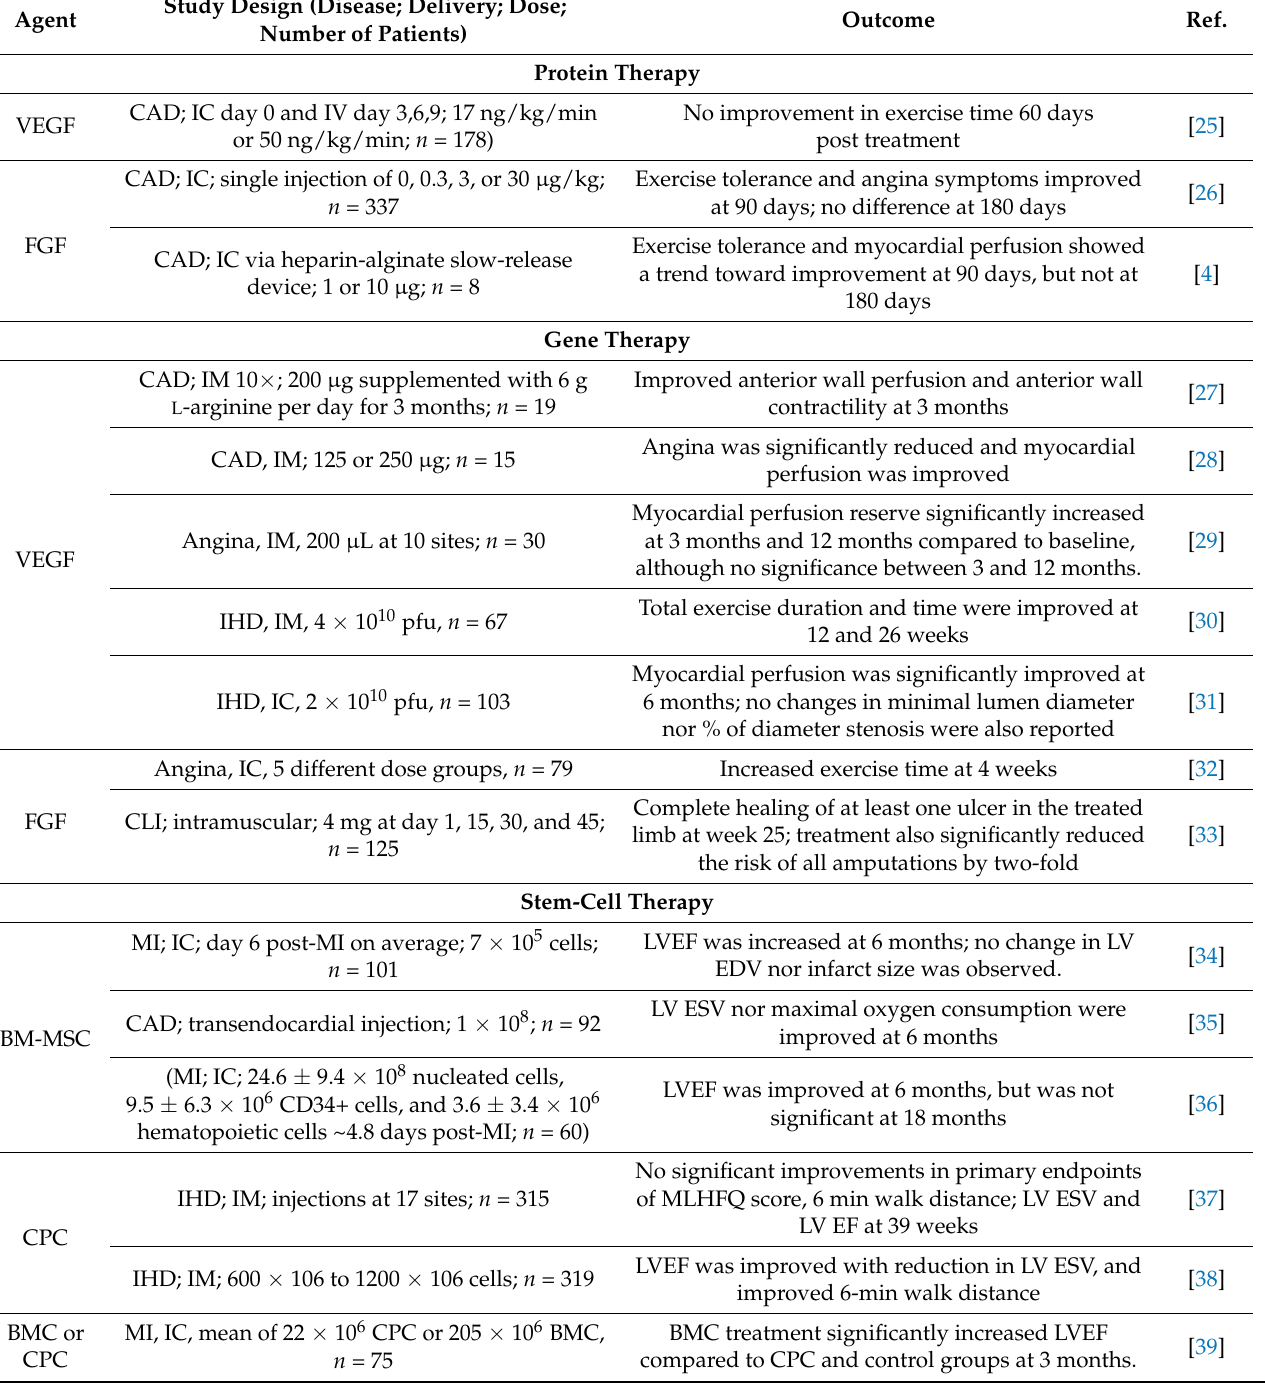
Table 1. Clinical outcomes with angiogenic